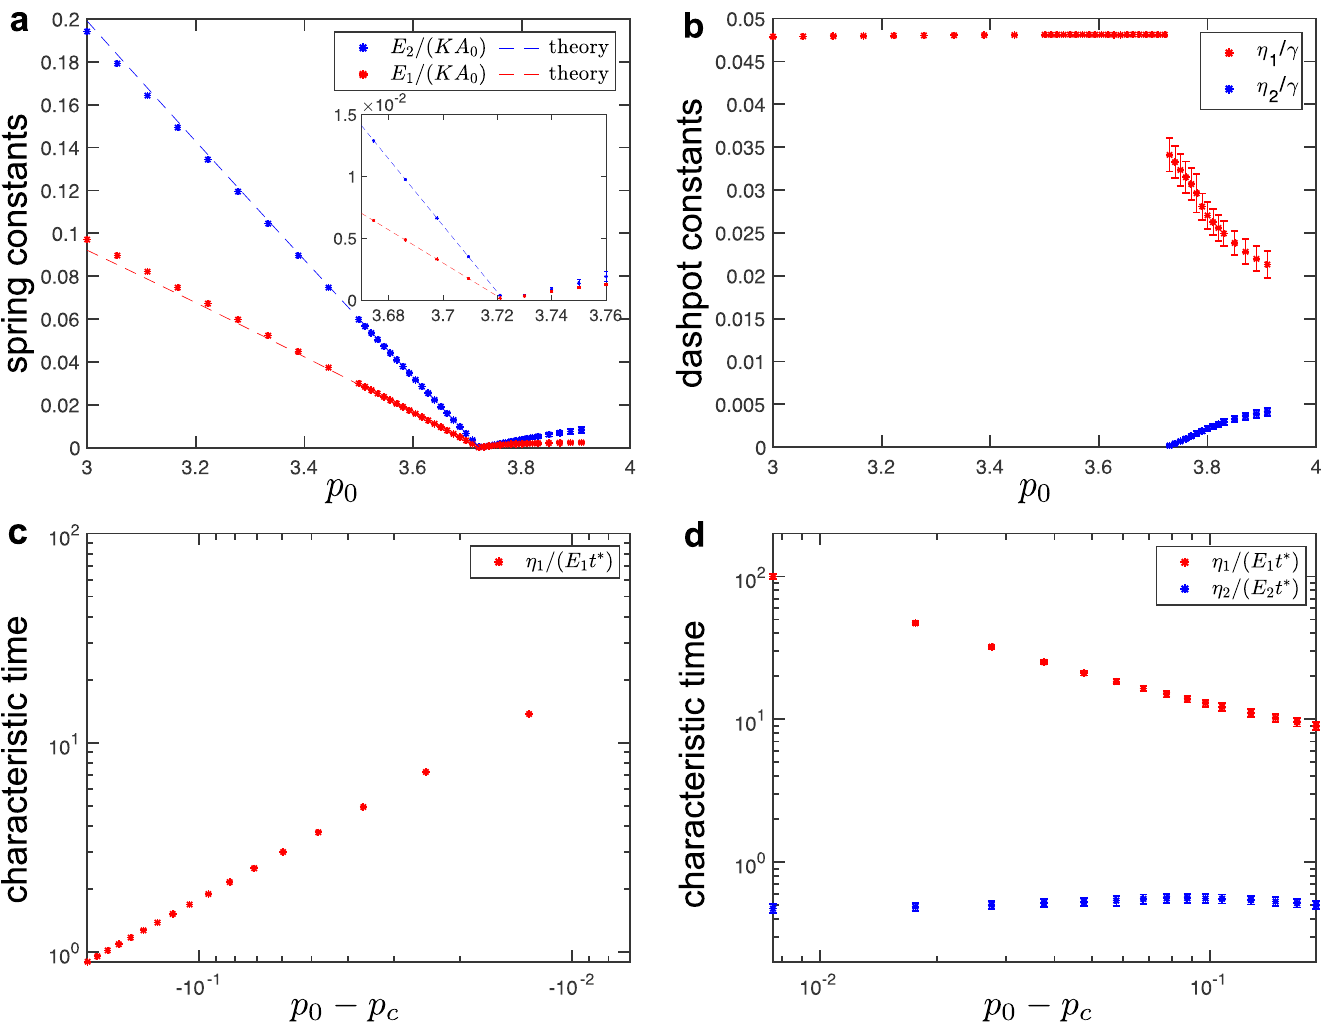
Fig 3. (a-b) Fitted values of spring-dashpot models for hexagonal tilings under simple shear. (a) Elastic constants as a function of target cell-shape parameter, p 0 . In the solid phase (i.e., for p 0 < p c � 3.722), fitted values of the spring constants show excellent match with the analytical predictions obtained from Eqs (6) and (7) (dashed lines). Inset shows the spring constants near the critical point. (b) Dashpot viscosity constants as a function of the target cell-shape parameter, p 0 . (c-d) Characteristic timescales in (c) the solid and (d) fluid phase for hexagonal tilings obtained from the fitted values of the elastic constant and the dashpot viscosity. The normalization factor t � = γ /( KA 0 ) sets the unit of time. For the fluid phase (i.e., for p 0 > p � 3.722), errorbars correspond to the standard deviation for simulations that were repeated c for configurations that correspond to different local energy